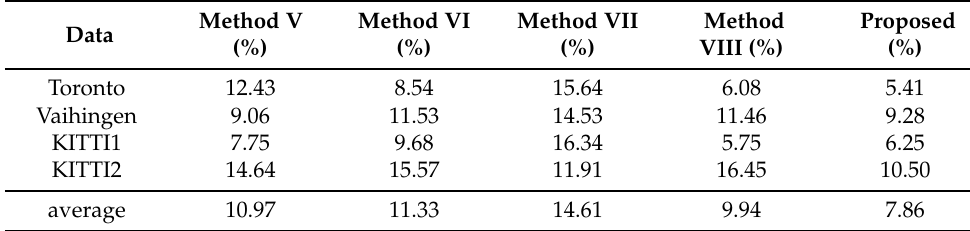
Figure 9. The results of the comparison between the method proposed in this article and the RANSAC plane fitting method. Green points are the ground points, blue points are the non-ground points. The red boxes in ( b , c ) are classified incorrectly. ( a ) The point cloud manually labeled. ( b ) The point cloud processed by the RANSAC. ( c ) The point cloud processed by the method proposed in this article. Table 2. Comparison of the total errors of the proposed method and other